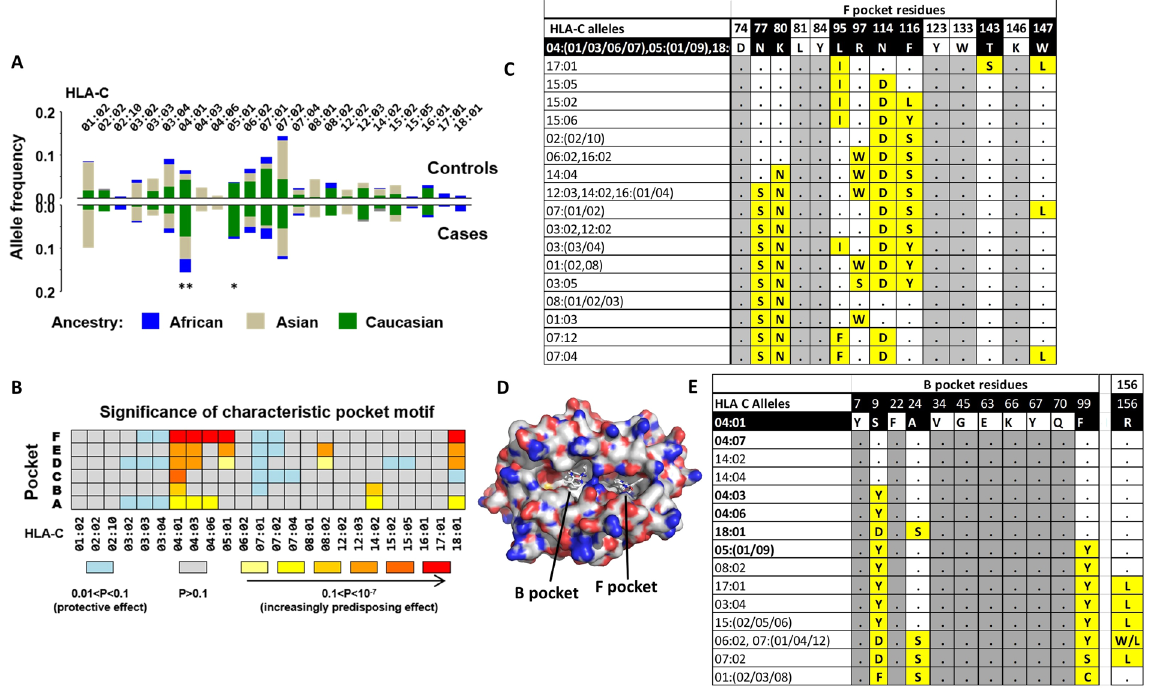
Figure 1. HLA-C alleles with shared F pocket and binding properties associate with cutaneous NVP HSR. Summaries of HLA-C alleles prevalent in this cohort ( ≥ 5 carriers). ( A ) Relative allele frequencies amongst cases (N = 151) and controls (N = 413) according to ancestral group. ** Carriage of HLA-C * 04:01 vs non-carriage: Odds ratio 3.06 (adjusted for ethnicity), P < 0.0001; * HLA-C * 05:01 : Odds ratio = 2.67, P = 0.002. ( B ) Heatmap illustrating impact on development of cutaneous NVP HSR for each HLA-C allele according to the relative significance of its characteristic motif across the HLA binding pockets A-F. Protective motifs are denoted by blue, and predisposing motifs range in color from yellow (weak effect) through to red (strongest effect). ( C ) Alignment of HLA-C F pocket sequences. Yellow highlighted positions show amino acids that are variable amongst the cohort alleles and conserved within the HLA-C risk group for cutaneous NVP HSR. ( D ) Molecular docking model showing preferred locations of NVP bound to the peptide binding groove of HLA-C * 04:01 within the B or F pocket as determined by positional scanning analysis. ( E ) Alignment of representative HLA-C B pocket sequences and position 156. Yellow highlighted positions show amino acids that are variable amongst the cohort alleles and conserved within the HLA-C risk group for cutaneous NVP HSR. NVP HSR risk alleles from this analysis with a common F pocket are shown in bold font. All other HLA-C alleles from the cohort with n > 5 are not shown and carry the HLA-B pocket common to risk alleles except at 9-Y(Tyr), 99-Y(Tyr), and 156 L/W/Q